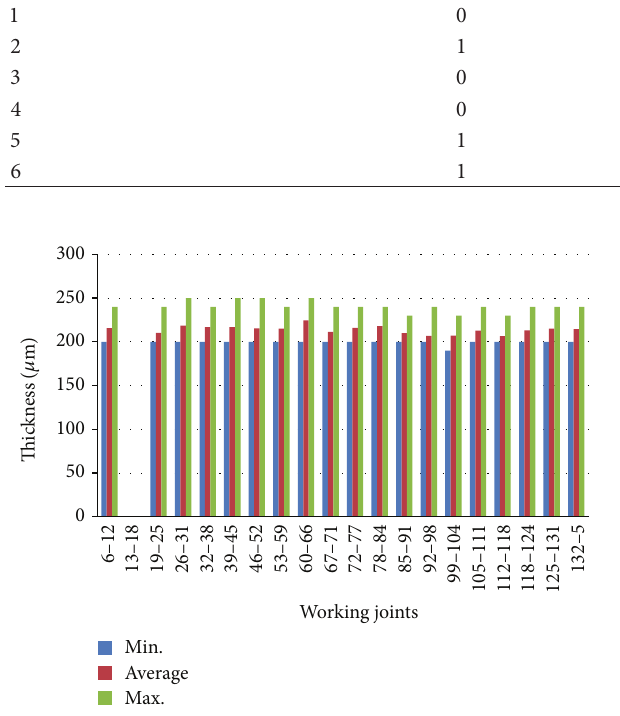
Figure 10: Overall thickness paintings external shell.